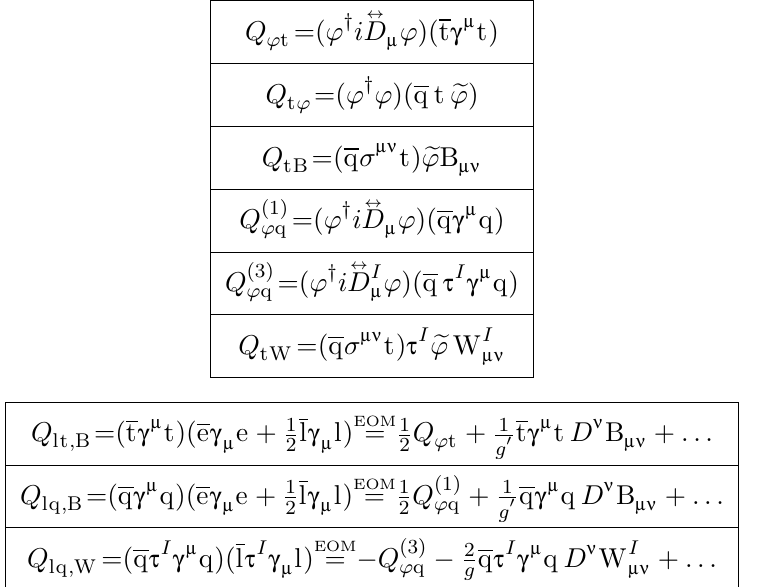
Table 3. The nine top-philic d = 6 operators considered in the present EFT analysis. All operators are those in [44], with the exception of Q , Q and Q , which are linear combinations of lt ; B lq ; B lq ; W Warsaw basis four-fermion operators. Note that the Hermitian conjugate is added to the Lagrangian for the operators Q , Q (1) , and Q (3) , in spite of the fact that they are manifestly real. Hence, ’ q ’ q ’ t